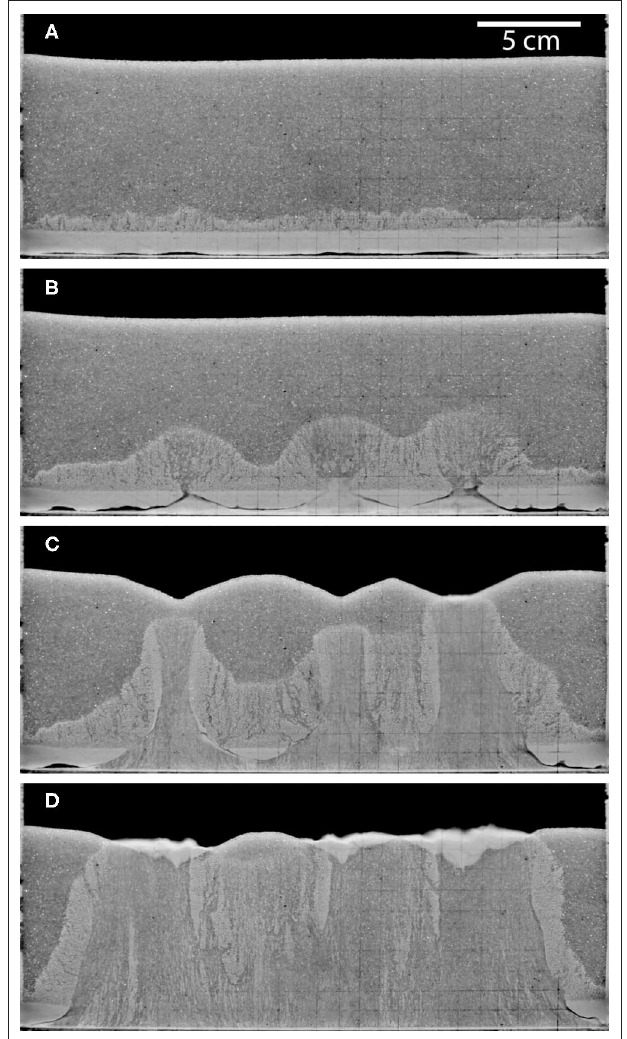
FIGURE 5 | Photographs of percolation behaviour in experiment with: r = 10.08, H f / H = 0.1, d f = 45–75 µ m, d c = 500–710 µ m.u = 5.0 cm/s and photographs (B–D) were taken 10s, 16s, and 28s after (A)